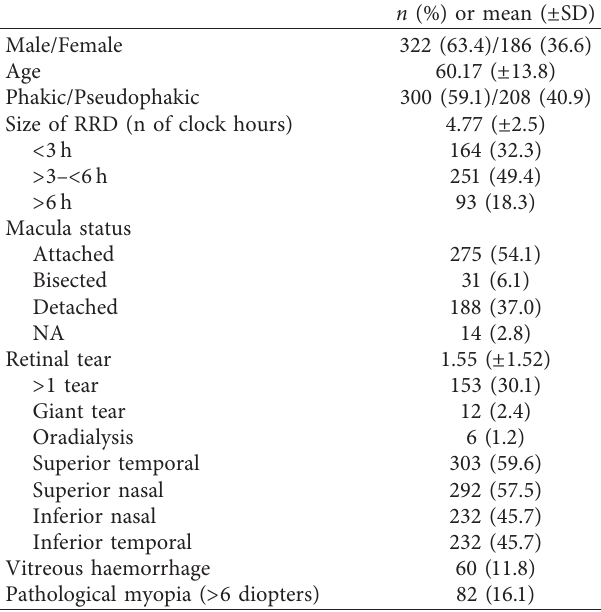
Table 1: Descriptive baseline